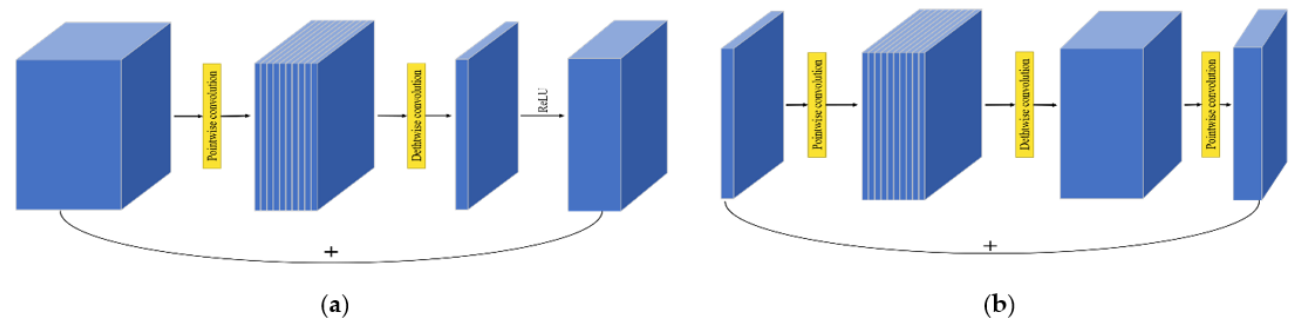
Figure 3. Comparison of two frameworks: ( a ) residual block, ( b ) IRB.